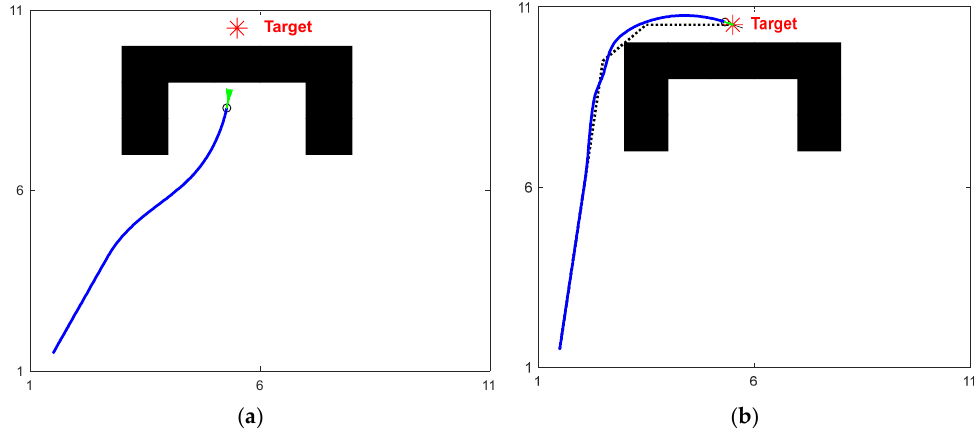
Figure 6. Comparison of robot behaviors. ( a ) DWA. ( b ) ACO–DWA.